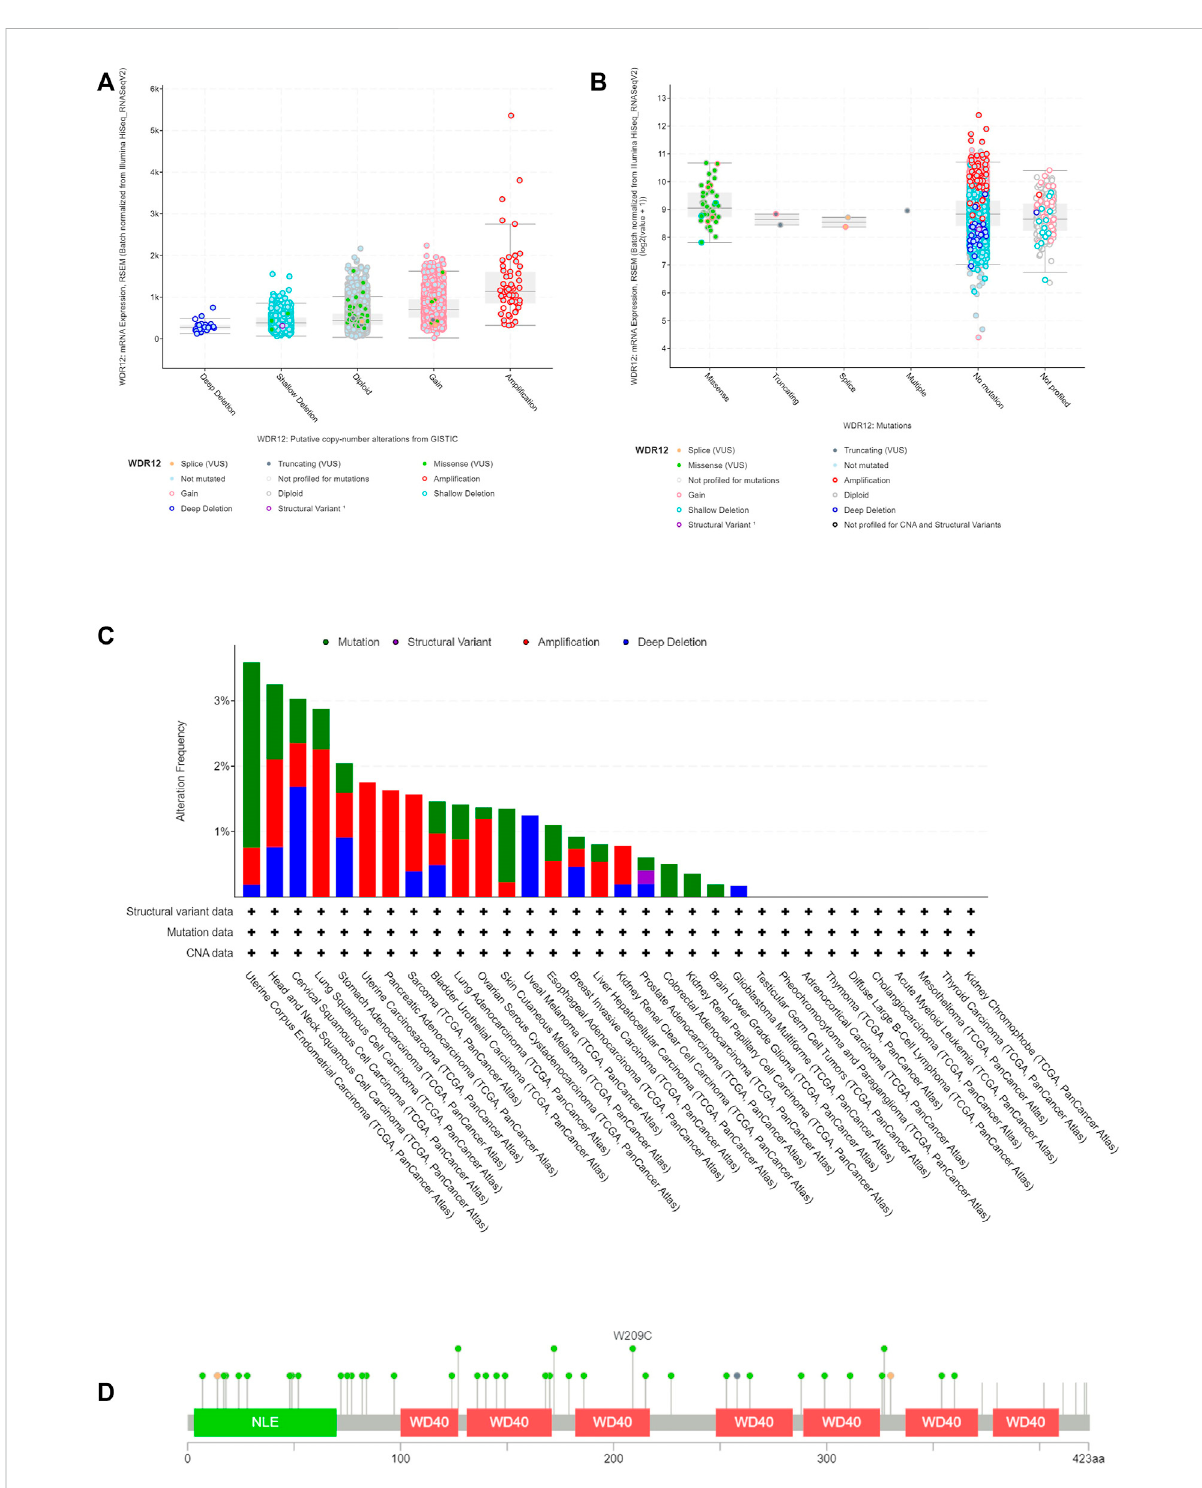
FIGURE 4 Mutation assessment for WDR12 using the cBioPortal tool. (A) Gene alteration analysis for WDR12; (B) mutation forms analysis for WDR12; (C) alteration frequency with mutation type in a panel of analyzed human cancers (D) map representation for sites and types of WDR12